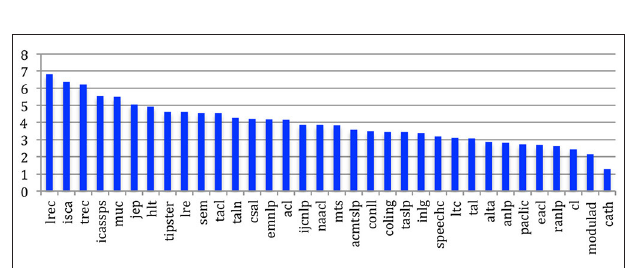
FIGURE 32 | Mean degree of the CollG for the 34